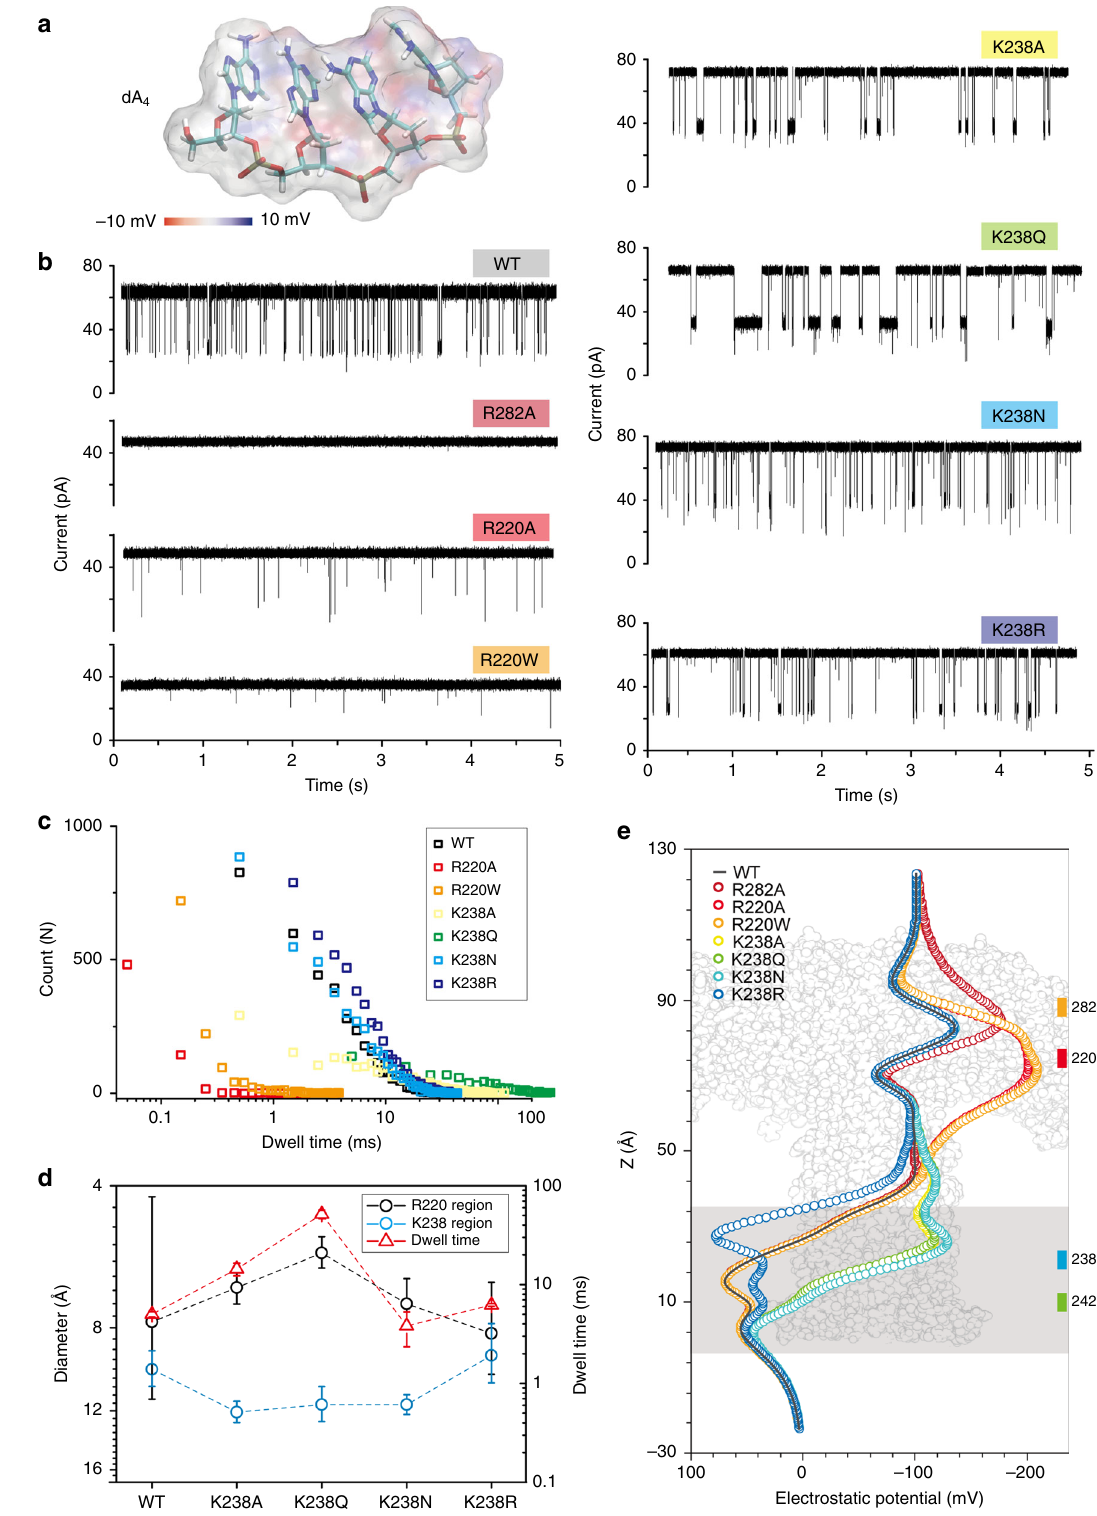
Fig. 3 DNA sensing by various engineered pores. a Structure of dA 4 with its electrostatic potential mapped on the molecular surface. b Raw single-channel recording traces upon dA 4 addition into the cis chambers of wt, R282A, R220A, R220W, K238A, K238Q, K238N, and K238R mutants, respectively. The fi nal concentration of dA 4 in the chamber was 2.0 μ M. c Dwell time distribution of dA 4 events of the wt (black, 5000 events), R220A (red, 5000 events), R220W (orange, 3200 events), K238A (yellow, 3800 events), K238Q (green, 4200 events), K238N (sky blue, 5000 events), and K238R (blue, 5000 events) mutants under + 100mV voltage. d Comparison between dwell time of dA 4 (red triangles) and the pore diameter at the R220 (black circles) and K238 (blue circles) regions. e Electrostatic potential maps of wt, R282A, R220A, R220W, K238A, K238Q, K238N, and K238R along the pore lumen. The lipid membrane region is represented by a gray shadow, and the R282, R220, K238, and K242 regions are marked with the colors scheme used along the manuscript fi gures (see Fig.